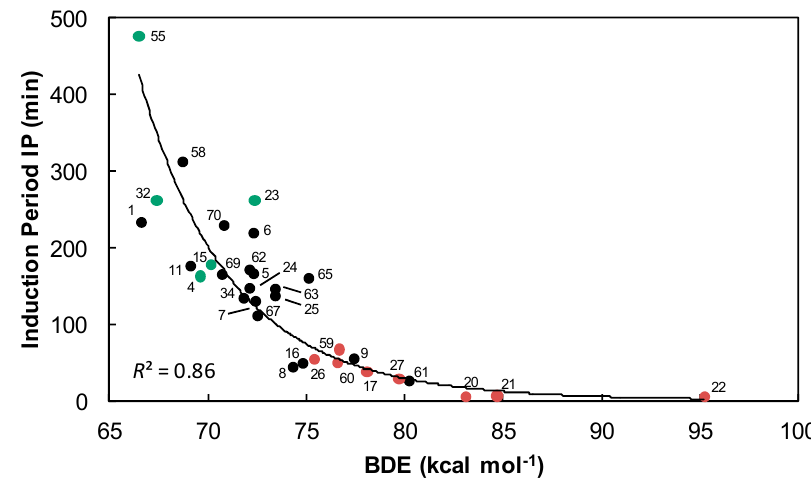
Figure 14. Induction periods (IP) as a function of the BDEs calculated with the B3LYP/6-311++G(2d,2p)//B3LYP/6-311G(d,p) DFT method, stoichiometric numbers are indicated